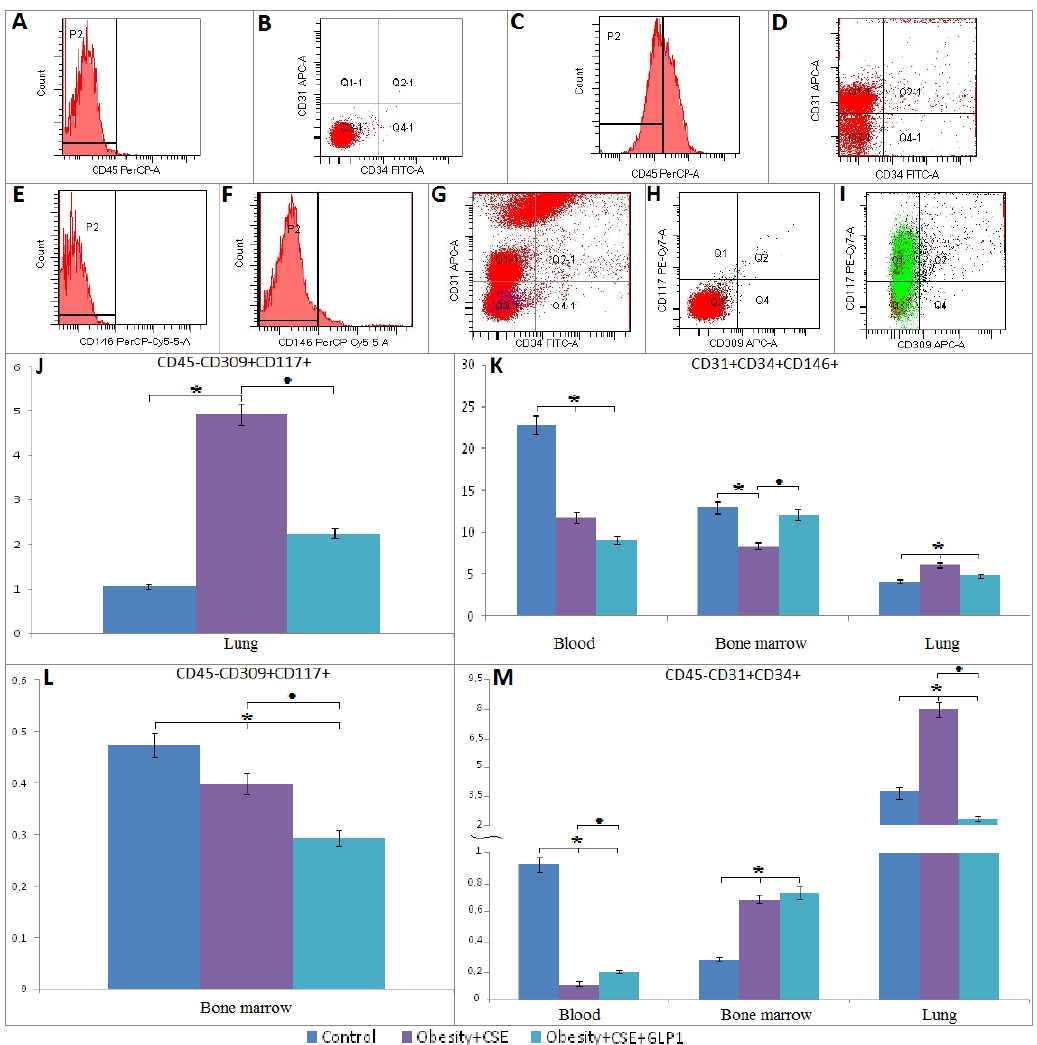
Figure 5. Characterization of endothelial cell population CD31 + CD34 + CD146 + , CD45 − CD31 + CD34 + , CD45 − CD117 + CD309 + isolated from blood, bone marrow, and lung of female C57BL/6 mice on the 188th day of the experiment. Cells were analyzed by flow cytometry using antibodies for CD45, CD31, CD34, CD146, CD117, CD309 mice. Dot plots are representative for three independent experiments with the mean from three independent experiments. ( A , B ) Isotypic control for IgG2a (PerCP), IgG2a (FITC) and IgG2b (APC). ( C , D ) Phenotype establishment and qualitative analysis of CD45 (PerCP), CD34 (FITC) and CD31 (APC) expression. ( E ) Isotypic control for IgG2a (PerCP-Cy5.5). ( F , G ) Phenotype establishment and qualitative analysis of CD34 (FITC), CD31 (APC), and CD146 (PerCP-Cy5.5) expression. ( H ) Isotypic control for IgG2b (PE-Cy7), and IgG2b (APC). ( I ) Phenotype setting and qualitative analysis of CD45 (PerCP), CD117 (PE-Cy7), and CD309 (APC) expression. ( J , L ) The content of angiogenesis progenitor cell (CD45 − CD117 + CD309 + ) in the lung ( J ) and bone marrow ( L ) of control mice, obese mice exposed to CSE, obese mice exposed to CSE and receiving GLP-1. ( K ) The content of endothelial cells with CD31 + CD34 + CD146 + phenotype isolated from blood, bone marrow, and lung of control mice, obese mice exposed to CSE, obese mice exposed to CSE and receiving GLP-1. ( M ) The content of endothelial cells with phenotype CD45 − CD31 + CD34 + isolated from blood, bone marrow, and lung of control mice, obese mice exposed to CSE, obese mice exposed to CSE and receiving GLP-1. *—significance of difference compared with control ( p < 0.05); (cid:4) —significance of difference compared with the obesity + CSE group ( p <